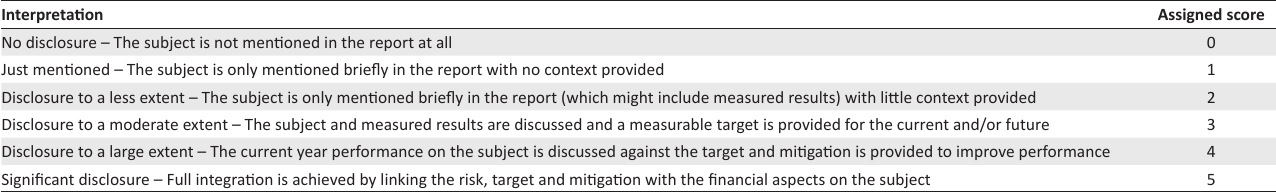
TABLE 1-A1: Likert scale scores and interpretation for corporate environmental disclosure